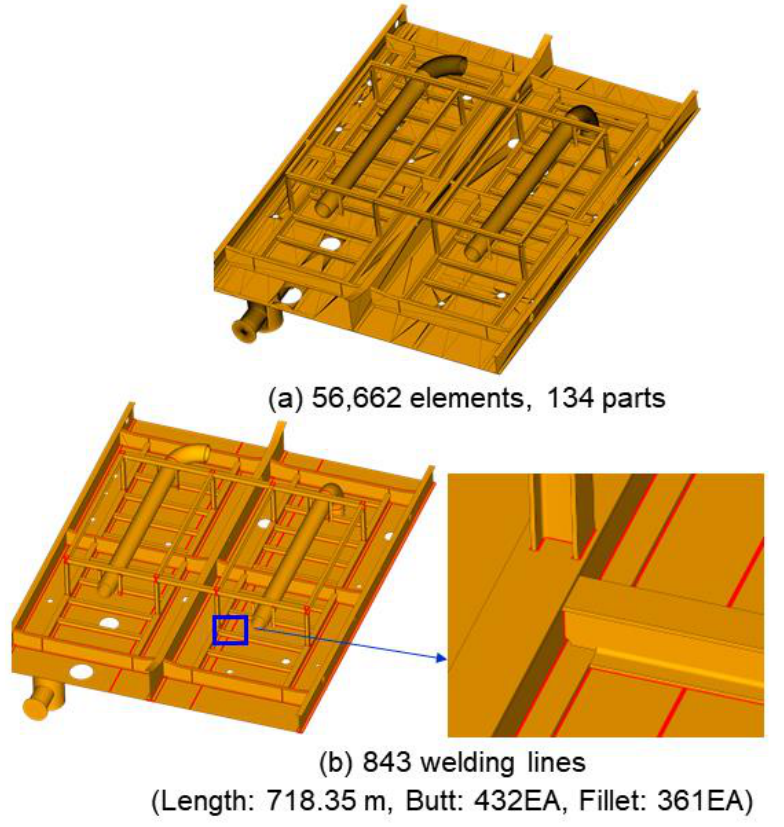
Figure 14. Weld line generation from a structural block.